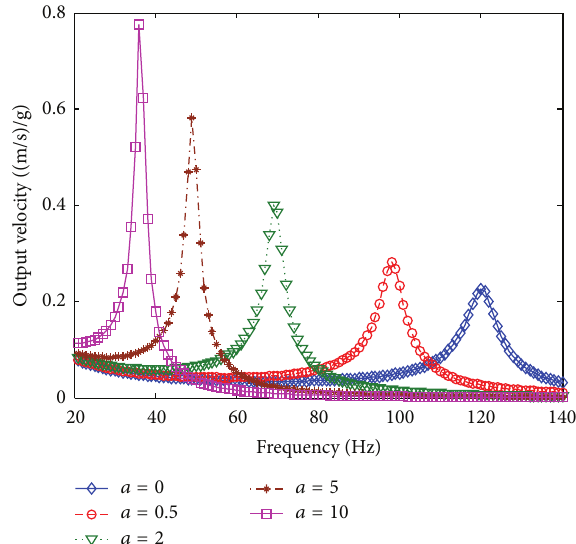
Figure 5: Output velocity for the PVEH with various mass ratios 𝑎 when 𝑅 𝐿 = 1 k Ω